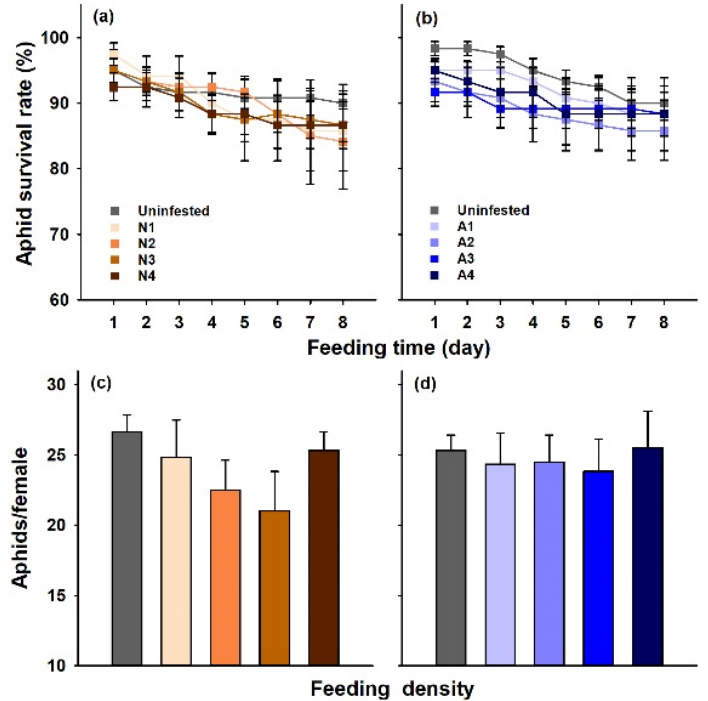
Figure 2. Performance of M. persicae on NahG plants infested by B. tabaci MEAM1. Survival rate of M. persicae on tobacco plants infested by B. tabaci MEAM1 nymphs ( a ) and adults ( b ) at different densities. Fecundity of M. persicae on tobacco plants infested by B. tabaci MEAM1 nymphs ( c ) and adults ( d ) at different densities. Error bars represent standard error of the means.